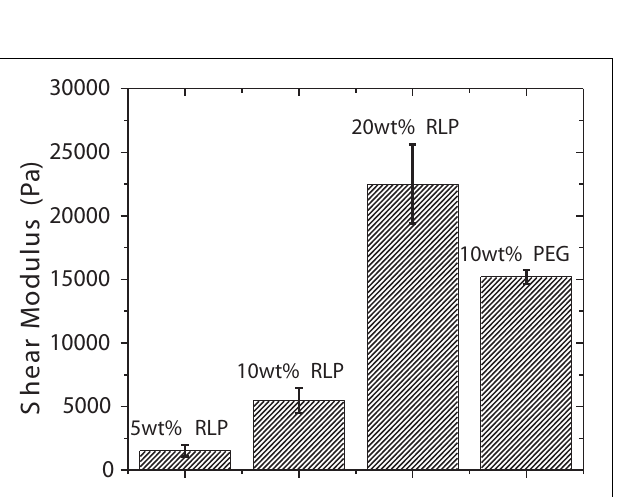
FIGURE 2 | Shear storage moduli of RLP and PEG hydrogels. Oscillatory time sweeps for in situ cross-linking of RLP and PEG hydrogels were conducted for 2h at 37 ◦ C at a frequency of 6rad/s and at1% strain. The final equilibrium storage modulus (G (cid:3) ) for each composition is reported. Error bars represent the standard deviation of three